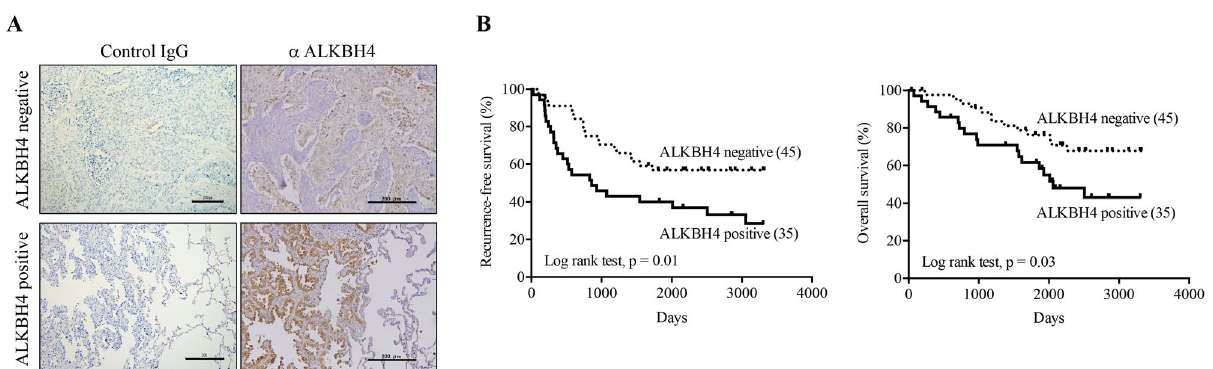
Figure 5. The expression of ALKBH4 and E2F1 of E2F1-target genes has a positive correlation in NSCLC clinical specimens. E2F1 ( A ) and E2F1-target gene (( B ) CCNE1 , ( C ) MYBL2 , and ( D ) CDC25A ) expression levels were measured using qPCR and were compared between normal and tumour tissues in NSCLC clinical specimens. Relative expression normalised to ACTB is shown. Data are represented as means ± S.D. ****p < 0.0001 for paired t -test. Correlation analysis was performed with the relative ALKBH4 expression and the relative E2F1 expression ( E ), CCNE1 expression ( F ), MYBL2 expression ( G ), and CDC25A expression ( H ) using 42-matched pairs of NSCLC samples. Pearson correlation analysis was conducted.